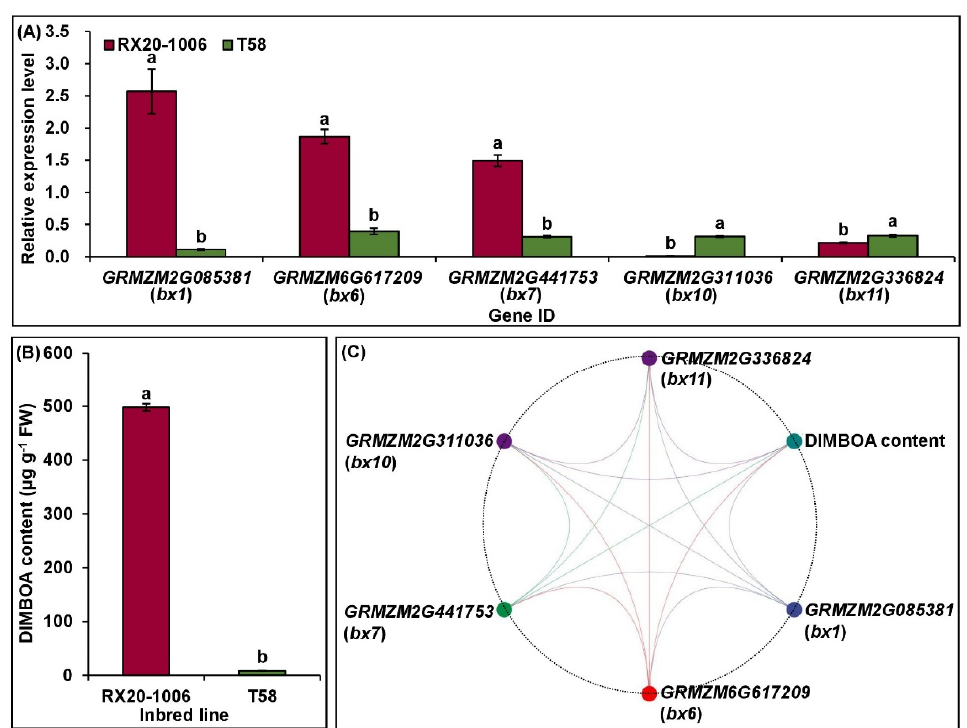
Figure 6. The relative expression level of five candidate genes involved in DIMBOA biosynthesis, DIMBOA content observation and their correlation in maize seedlings of RX20 ‐ 1006 (high insect ‐ resistant line) and T58 (insect ‐ susceptible line) in Zhangye (E1) environment, Gansu Province, China. ( A ) The relative expression level (mean ± standard deviation) of the five candidate genes; different lowercase letters indicate a significant difference ( p < 0.05) in gene expression. ( B ) DIMBOA content (mean ± standard deviation) in high insect ‐ resistant (RX20 ‐ 1006) and insect ‐ susceptible line (T58); different lowercase letters indicate a significance difference ( p < 0.05) in DIMBOA content. ( C ) The correlational relationships between the relative expression level of five candidate genes and DIMBOA content; lines represent significant correlations ( p < 0.05).